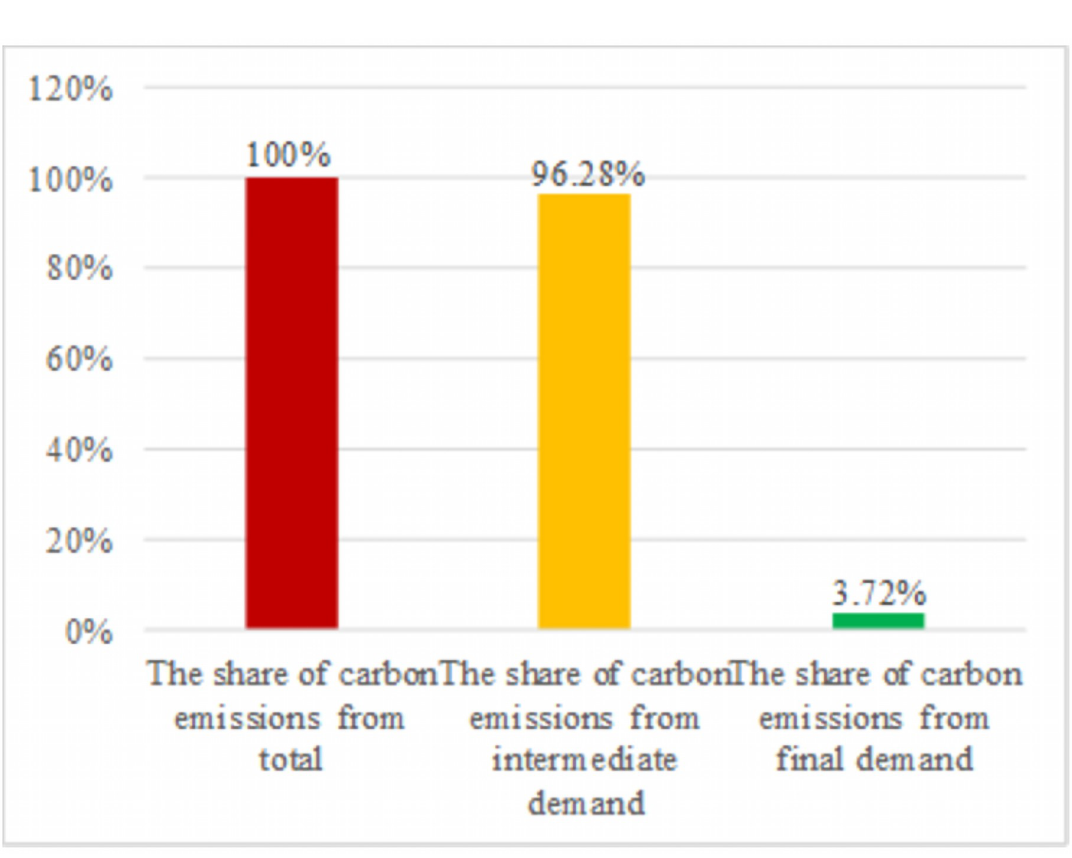
Fig 4. The demand structure of carbon emissions under baseline scenarios.